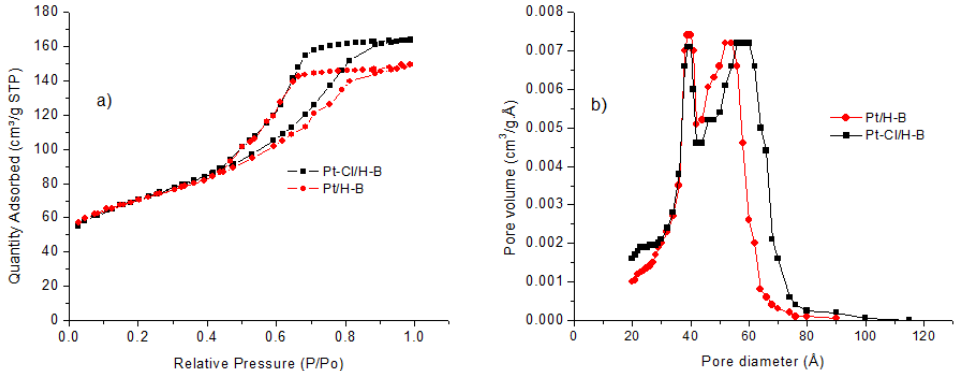
Figure 2. FTIR analysis of zeolites using pyridine as a probe molecule: results consist of ( a ) SiO 2 , ( b ) Al 2 O 3 , ( c ) H -β and ( d ) Cl- H -β.